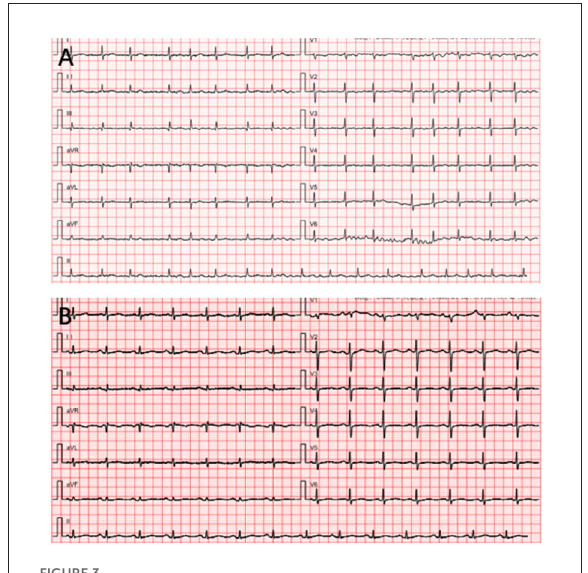
FIGURE3 Patient’s electrocardiogram (ECG). (A) The preprocedure ECG reveals atrial fibrillation. (B) The postoperative ECG of the patient when she felt palpitations and chest